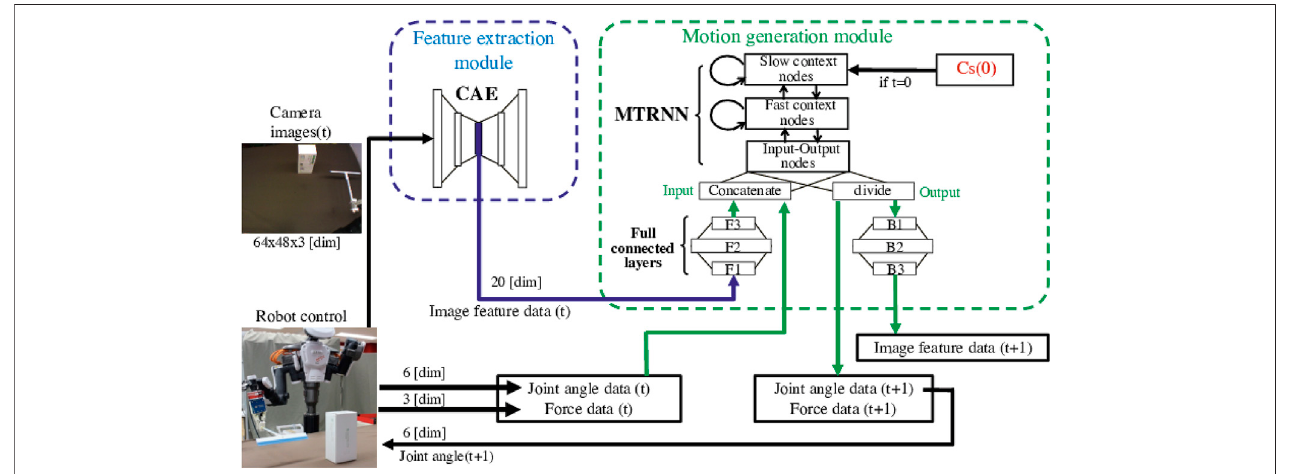
FIGURE1| Thetool-usemodeltocontroltherobottoconducttasks.Itcomprisesafeatureextractionmoduleandamotiongenerationmodule.Intests,at fi rst,the internal latent space value Cs(0) is explored using a goal image. The Cs(0) detects and expresses features of the tool, object, and actions needed to produce the target effects. For generating a motion, the feature extraction module compresses the number of dimensions in image data and extracts low-dimensional image feature data. Then the motion generation module simultaneously learns image feature data, joint angle data, and force data at the moment, and predicts next-step data. The robot is controlled according to the predicted joint angle data